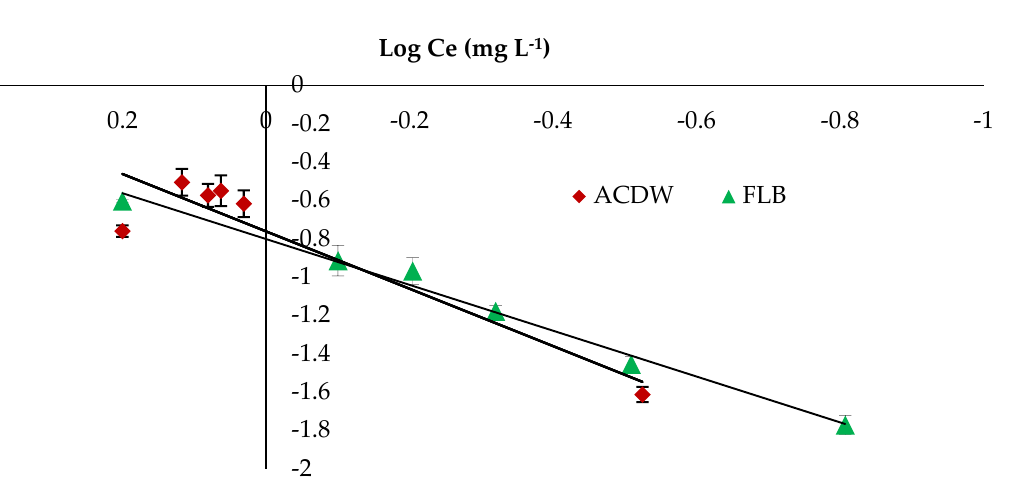
around the nature of adsorption. From this study, the average R L was obtained to be 0.877 Figure 8. Langmuir isotherm plot for removal efficiency of IV2R dye. and 0.994 for concentration of 10–100 mg L − 1 of IV2R dyes for ACDB and LFB, respectively; as displayed in Table 3, the value data of R L indicated the type of Langmuir equation to be favorable (0 < R L < 1), irreversible (R L = 0), unfavorable (R L > 1), and linear (R L = 1) [35]. They are in the scope from 0–1, which describes the favorable adsorption process. Freundlich isotherm gave a better fit for IV2R with a higher correlation coefficient of 0.988 for LFB adsorbent, while this model gave a lower fit by ACDB adsorbent with correlation coefficient 0.856 as shown in Figure 9 and Table 3. On the other hand, the Freundlich constant “K f ” displays the sorption capacity on heterogeneous sites with non-uniform spreading of the energy level and can work as indicators for the maximum adsorption capacity of the dye cation from the adsorbent. The value of the “n” parameter of the Freundlich equation can act as an indicator on the favorability of adsorption and shows the intensity among dyes and biomass. The “K f ” values were 5.76 and 6.3 for both ACDB and LFB adsorbents, respectively. Moreover, a strong bond is existent among two adsorbents, as shown via the data of 1/n, “called the heterogeneity factor”, describing the deviation from the linearity of adsorption as follows: when 1/n is below 1, chemical adsorption happens, and this demonstrates an ordinary Langmuir isotherm; however, when 1/n is further than 1, cooperative adsorption takes place, and the sorption process is more favorable physically and comprises strong interactions between the particles of the dye solution; when 1/n is equivalent to 1, the adsorption is linear, and the dye particle concentration does not influence the division between the two stages [34]. In this study, the values of factor “1/n” are less than 1 for ACDB and LFB adsorbents; the values show a physical adsorption method on an external surface with this equation to be favorable.